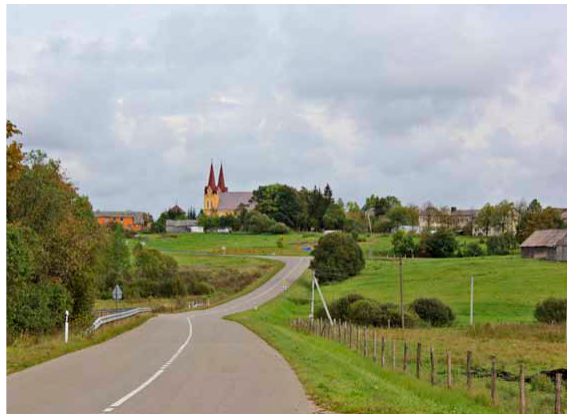
fig. 24. Villages with church towers and rich greenery form the distinct components of the rural cultural landscape (the Medingėnai church village in the rietavas municipality).